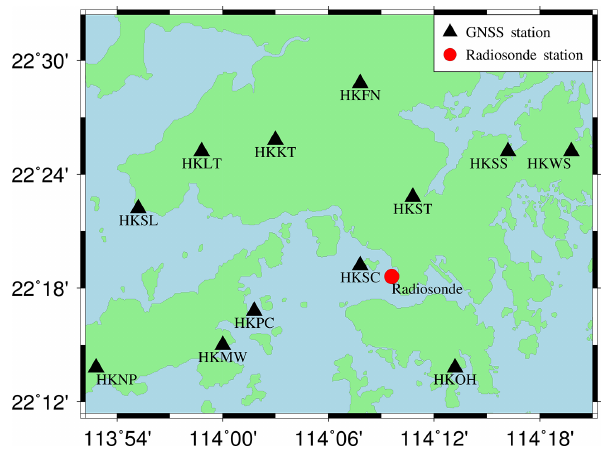
Figure 3. Geographic distribution of the Hong Kong Satellite Posi- tioning Reference Station Network (SatRef) and radiosonde station.